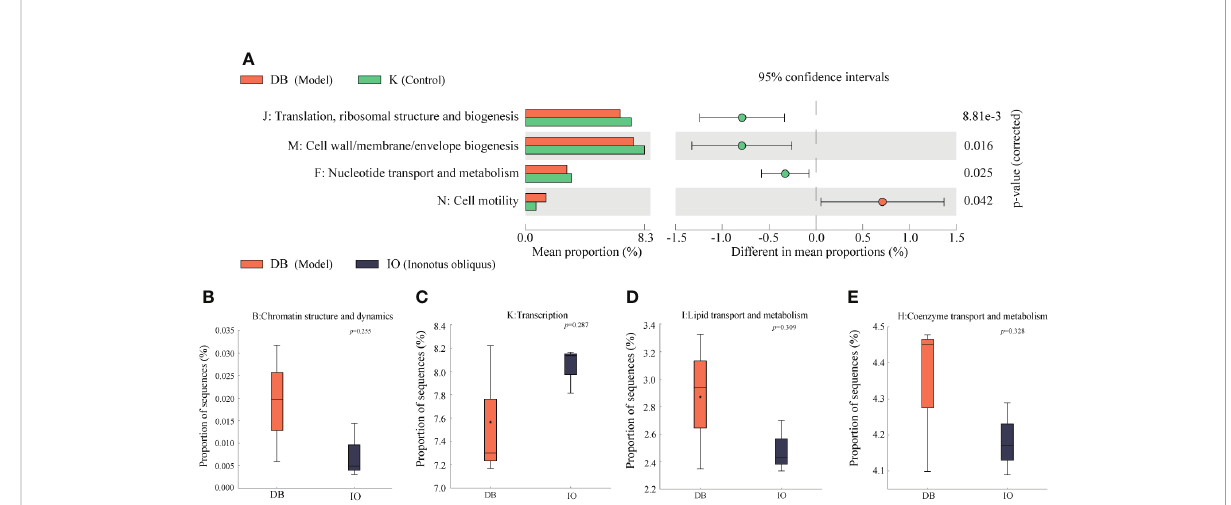
FIGURE 7 Function prediction. (A) Analysis of the differences in the prediction of intestinal fl ora function based on COG pathway between DB group and K group. Analysis of the differences between the DB group and the IO group in the functions of (B) Chromatin structure and dynamics, (C) Transcription, (D) Lipid transport and metabolism, and (E) Coenzyme transport and